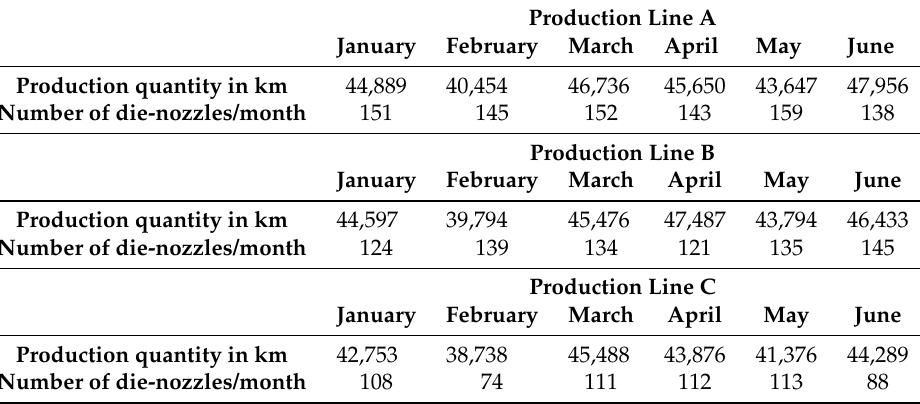
Table 3. Number of km produced by cable vs. the number of die-nozzles/month, used for each production